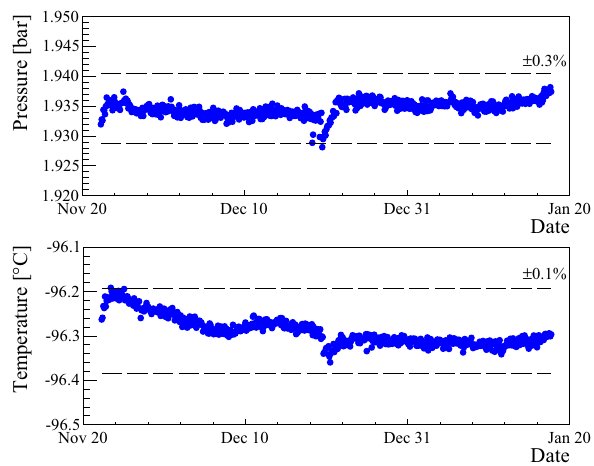
Fig. 14 Xenon gas pressure (top) and liquid xenon temperature at the TPC’s half-height (bottom) measured by the XENON1T slow control systemoveraperiodoftwomonths,duringsciencerun0.Thedipintem- perature and pressure around December 19 is from a